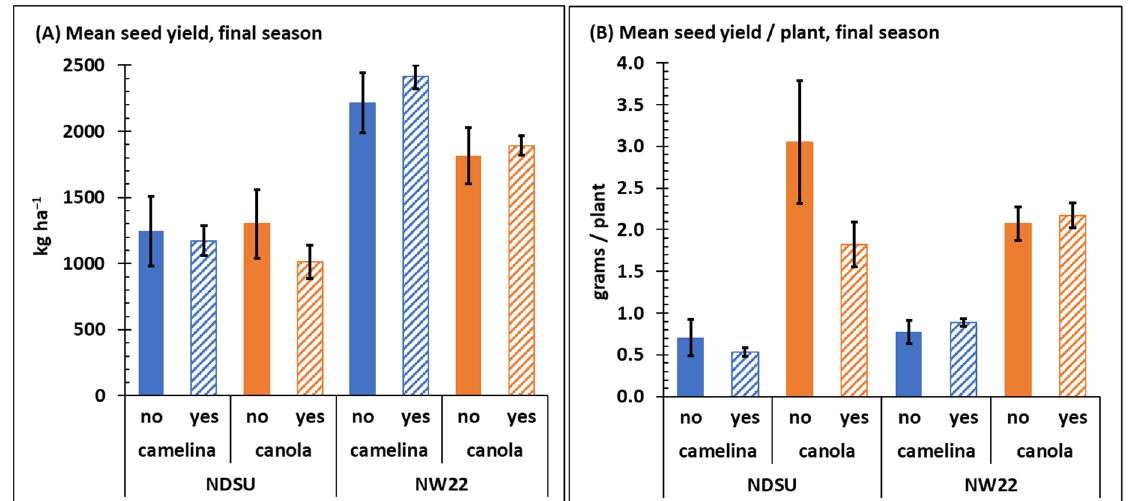
Figure 4. Mean seed yield kg ha − 1 ( A ) and grams/plant ( B ) collected from sulfonylurea-resistant camelina and canola at NDSU and NW22 field plots treated with (yes) or without (no) sulfonylurea herbicide. Seed was collected at final-season crop maturity. Error bars represent the standard error of the mean.